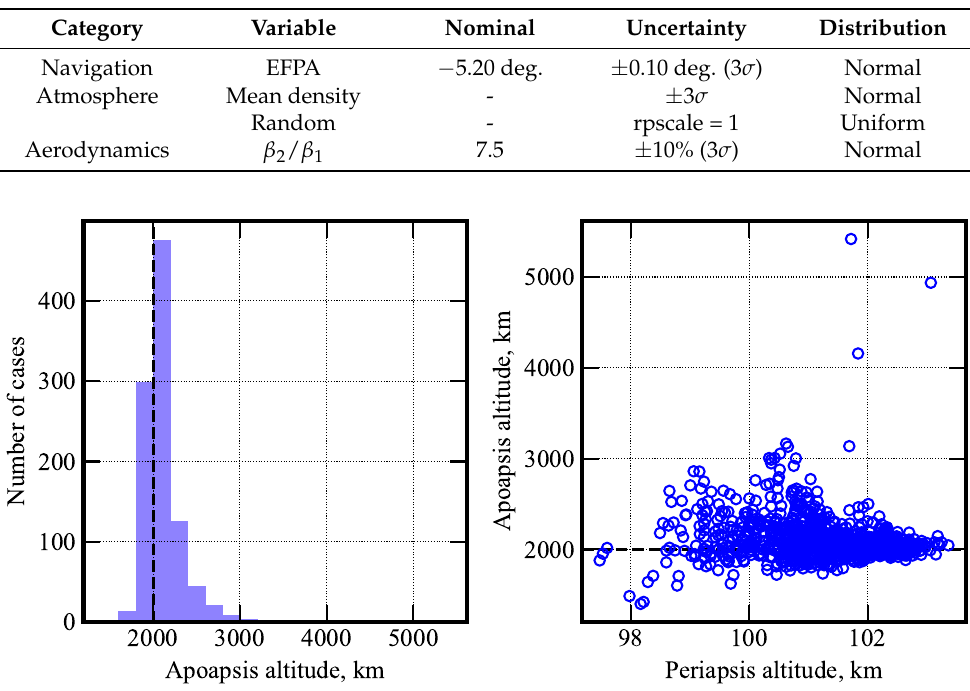
Figure 21. Histogram of the apoapsis altitude ( left ) and the apoapsis altitude and periapsis alti- tude ( right ) for Venus aerocapture. The black dashed line indicates the target apoapsis altitude of 2000 km.